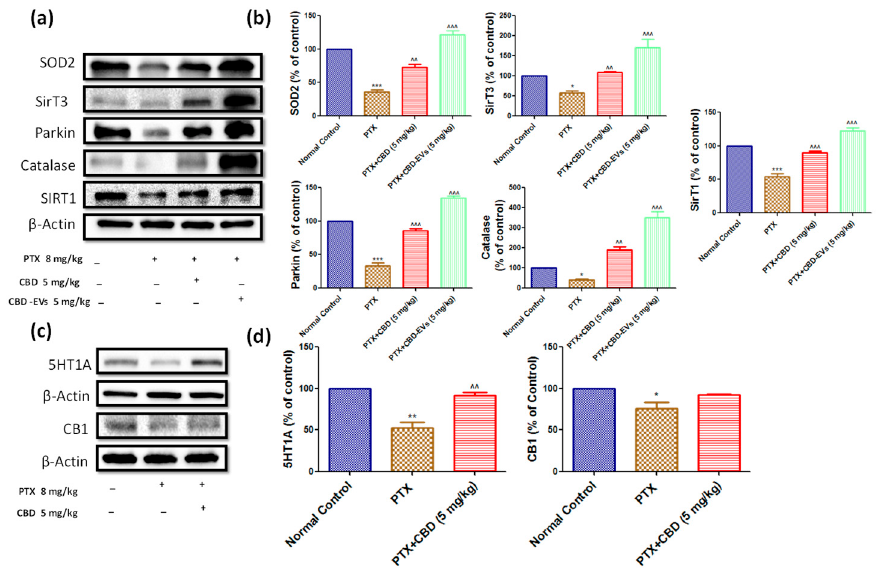
Figure 6. Effect of CBD and CBDEVs on AMPK-SIRT1-NRF1/2 Axis in spinal homogenates and effect of CBD on CB1 and 5HT1A receptors expression in DRG homogenates of PTX induced neuropathic mice. ( a ) Western blots of spinal homogenates show treatment with CBD (5 mg/kg) and CBD-EVs (5 mg/kg) and ( c ) Western blots of DRG homogenates show treatment with CBD (5 mg/kg) in PTX-treated mice for six weeks after last dose of PTX administration. ( b , d ) Bar graphs represent the respective western blots quantification. Values are expressed as mean ± SEM (n = 3). * p < 0.05, ** p < 0.01 and *** p < 0.001 vs. Normal control, ˆˆ p < 0.01 and ˆˆˆ p < 0.001 vs. PTX (8 mg/kg). NC: untreated age-matched mice, PTX: mice received (8 mg/kg/day) on alternate days for four injections cumulatively, PTX + CBD (5 mg/kg): 5 mg/kg CBD (i.p.) injected twice a week for six weeks after